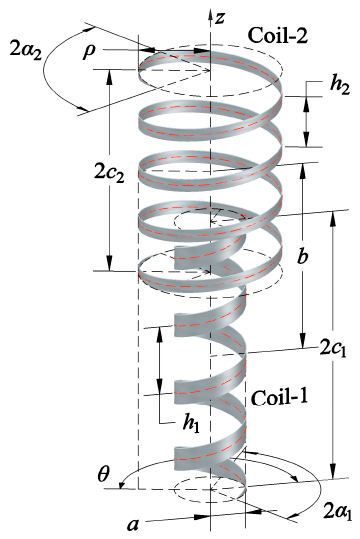
Figure 3. Mathematical model of finite-length coaxial helical tape coils.